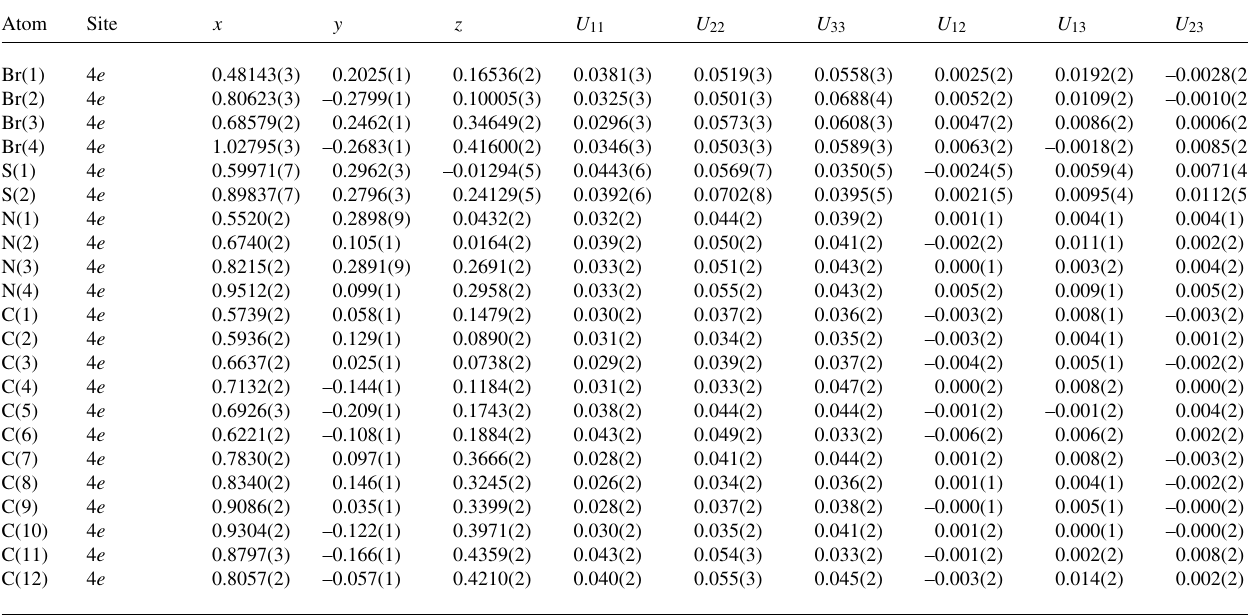
Table 3. Atomic coordinates and displacement parameters (in Å 2 )